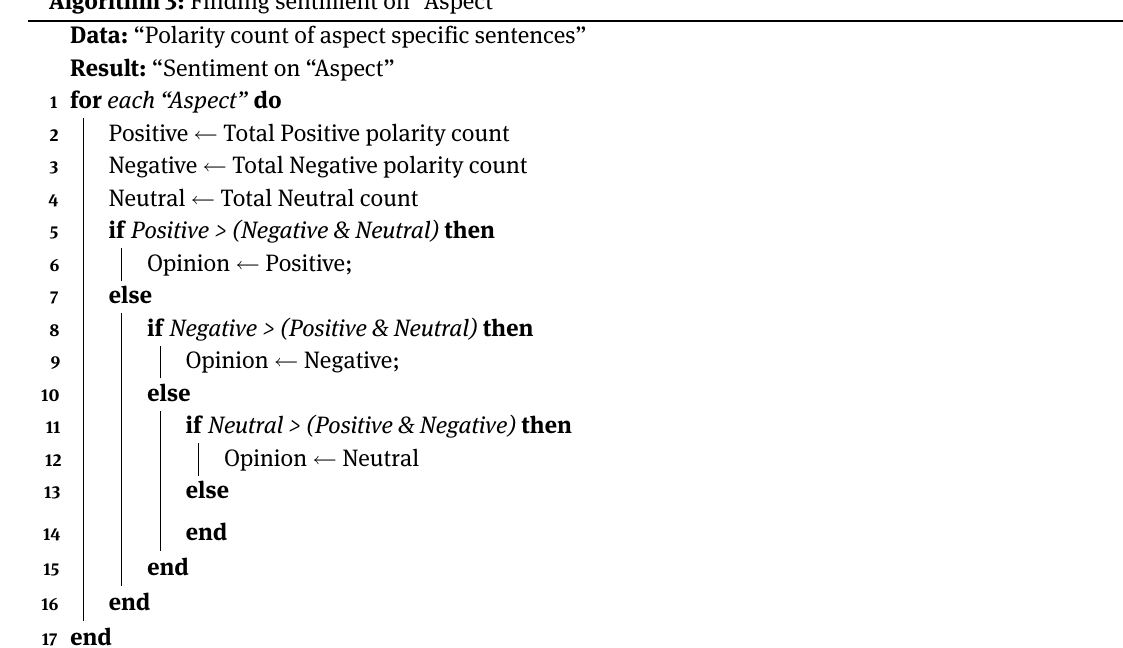
Algorithm 3: Finding sentiment on “Aspect” Data: “Polarity count of aspect specific